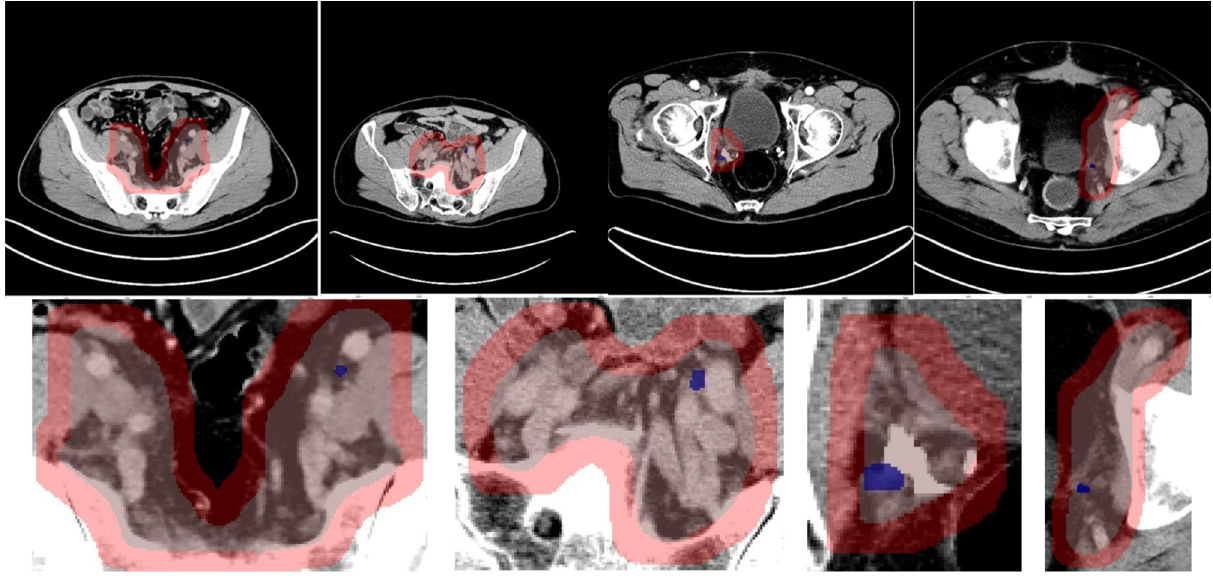
Figure 4. Visualization of positive pelvic LN GT and CTV masks. Below are two-image-paired examples selected from four different patients. For each pair, the first row is WSI with light red mask showing RTOG pelvic LN CTV and dark red mask showing the expanded zones, the second row is the enlarged subregion of its corresponding patient to better visualize the positive metastatic tumors (in